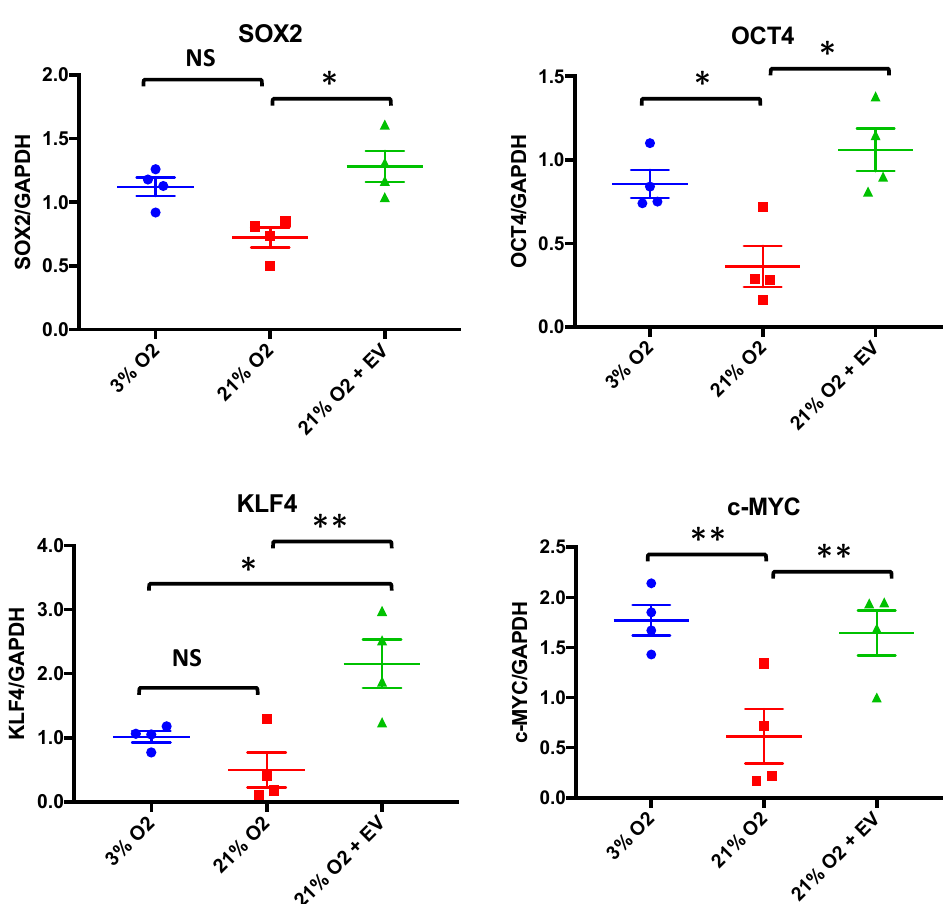
Figure 4. EVs restore pluripotency in premature senescent cells. SOX2, OCT4, KLF4 and cMYC mRNA levels relative expressions in hDPSCs, cultured at 3% O 2 and hDPSCs, cultured at 21% O 2 with or without EV treatment. The data are shown as means ± SD ( n = 4). Statistical significance is expressed as * p < 0.05; ** p < 0.01. NS means no significance.